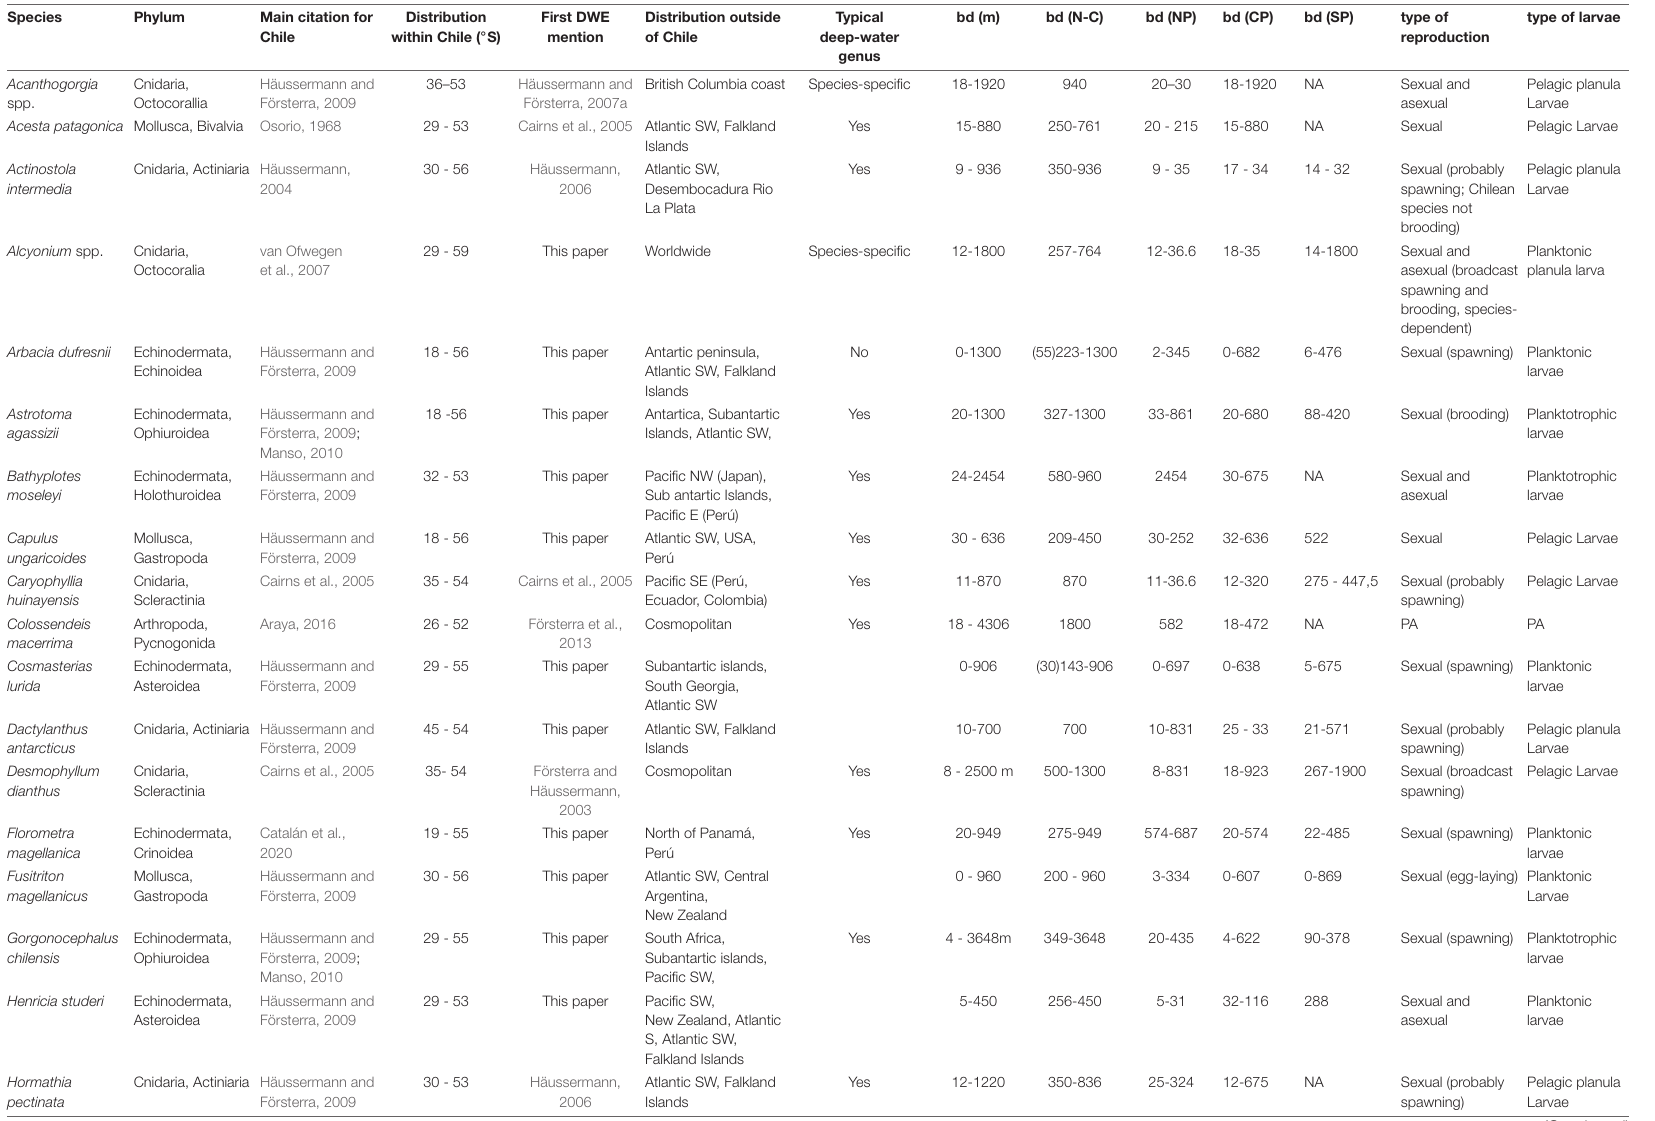
TABLE 1 | List of deep-water emergent species from Chilean Patagonia: geographic and bathymetric distribution (bd) for North and Central Chile (N-C), North Patagonia (NP), Central Patagonia (CP), and South Patagonia (SP) main citation for Chile and first citation of deep-water emergence (DWE), typical deep-water species, type of reproduction and larvae.